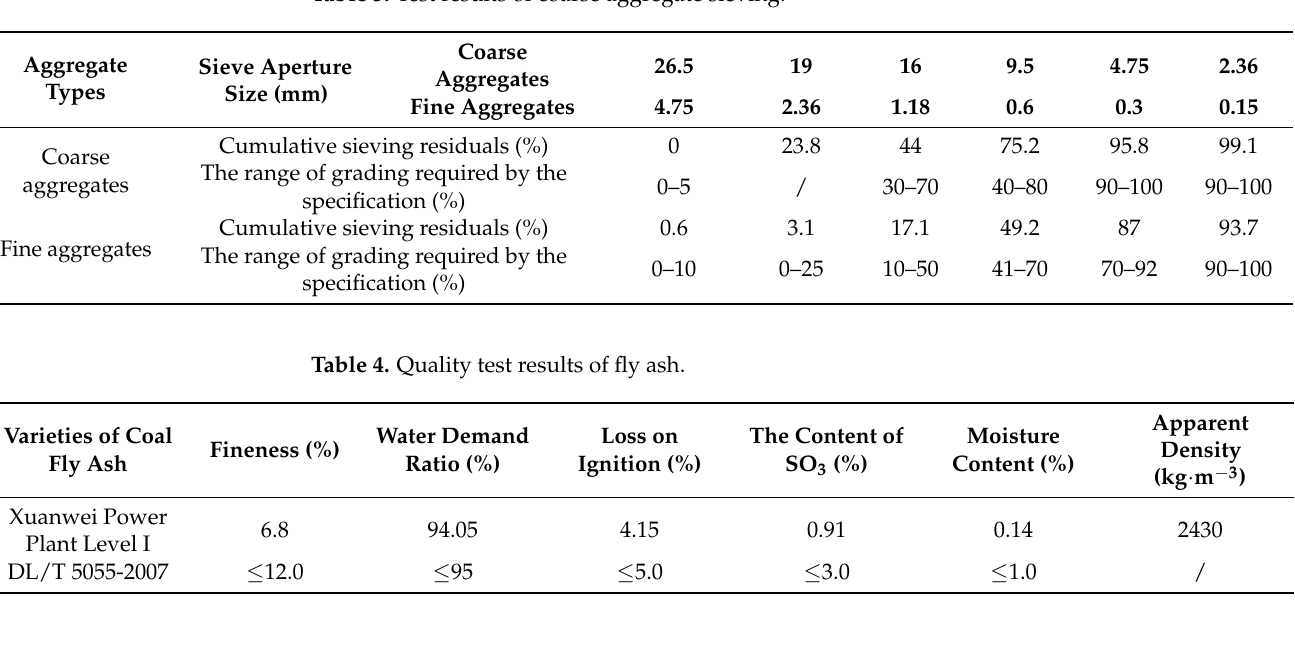
Table 3. Test results of coarse aggregate sieving.